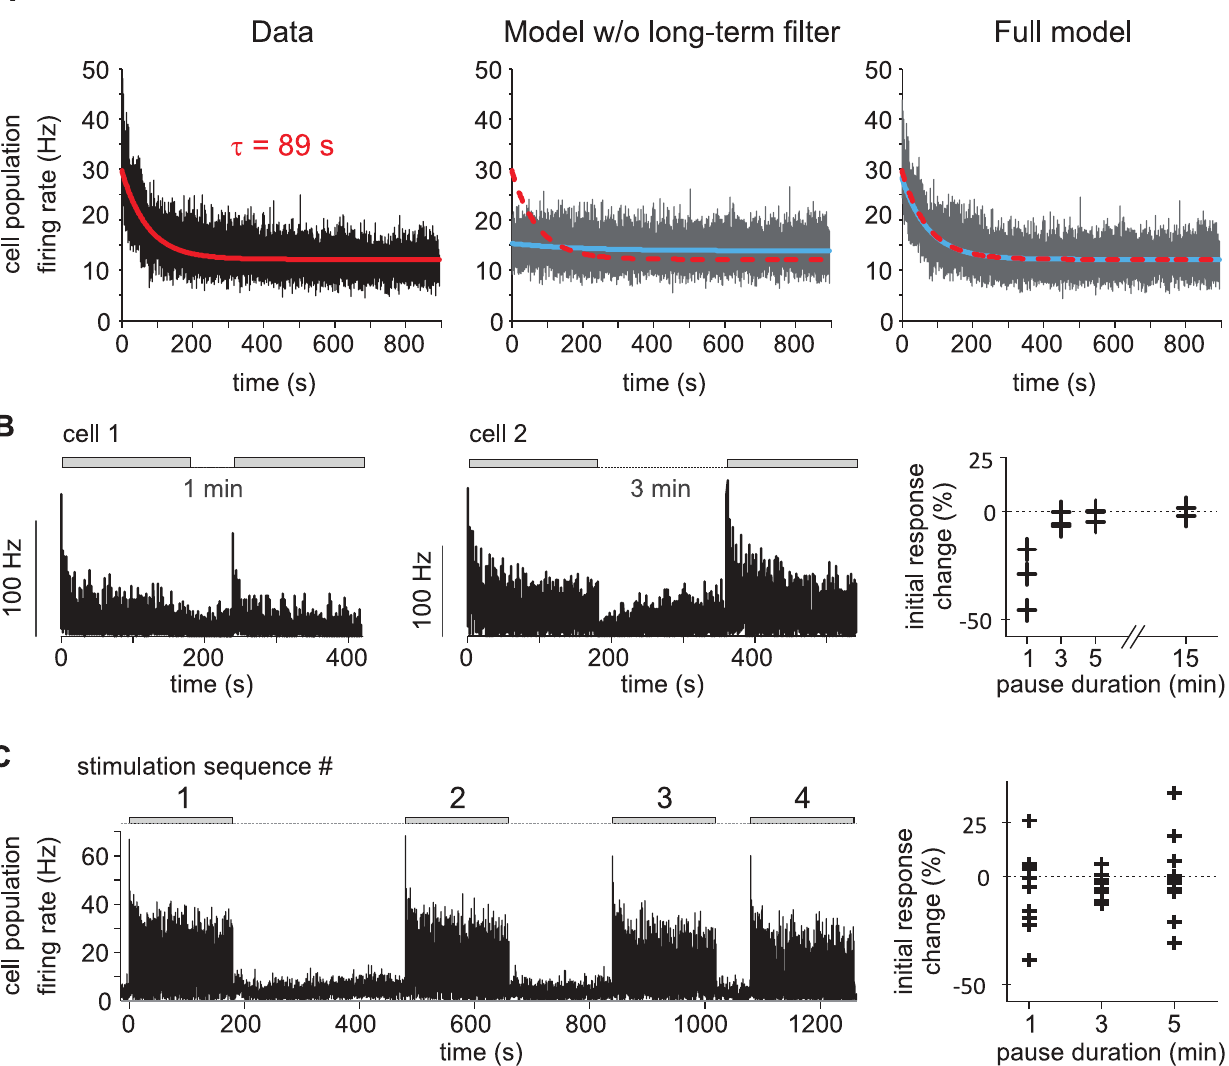
Fig 2. A reversible long term adaptation to dynamical stimuli is only captured with a long-term filter. (A) ORN responses to long duration white-noise stimuli and L-N model fits. Firing rate measuredin cell population(left), predicted by L-N models without long-term filter (middle)and predictedby the full L-N model used in the paper (right). Red and dotted red: exponential curve fitted to the data, blue: exponentialcurves fitted to the model prediction. (B) The slow adaptationis reversible. Left: example of ORN response to two 3-min-longnoise sequences(grey area) interleavedby a 1-min-long pause. The initial response(maximal firing rate in the first 5 s) to the beginningof the second noise sequenceis smaller. Middle:exampleof ORN responseto two 3-min-longnoise sequencesinterleavedby a 3-min-long pause. The initial responseto the second noise sequenceis similar to the initial responseto the first sequence.Right: initial responsechangesin ORNs dependon the pause duration(cell population= 11). (C) PN population response to 4 consecutivefrozen noise sequences(n = 16 cells). The noise sequence(grey areas) was 3-min long and its repetitions were interleaved by respectively5, 3 and 1 min pauses. Right: initial responsechangesin PNs (n = 10).